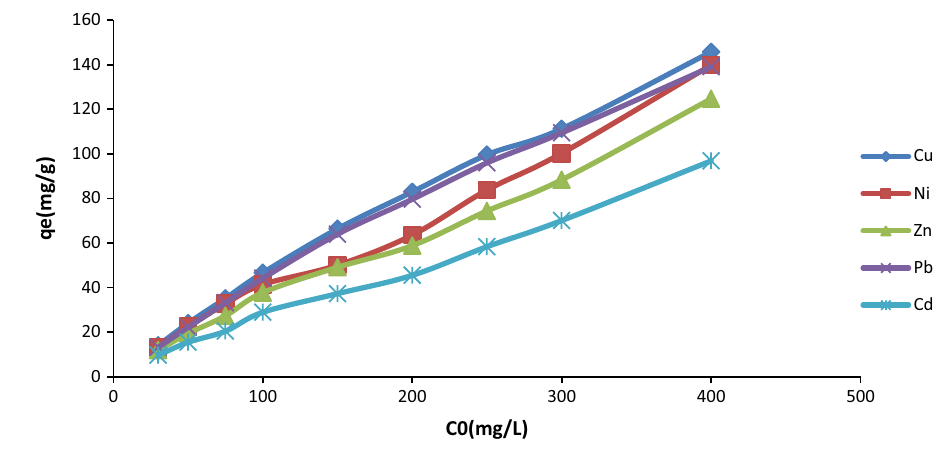
Fig. 5 Effect of initial concen- tration of M(II) onto